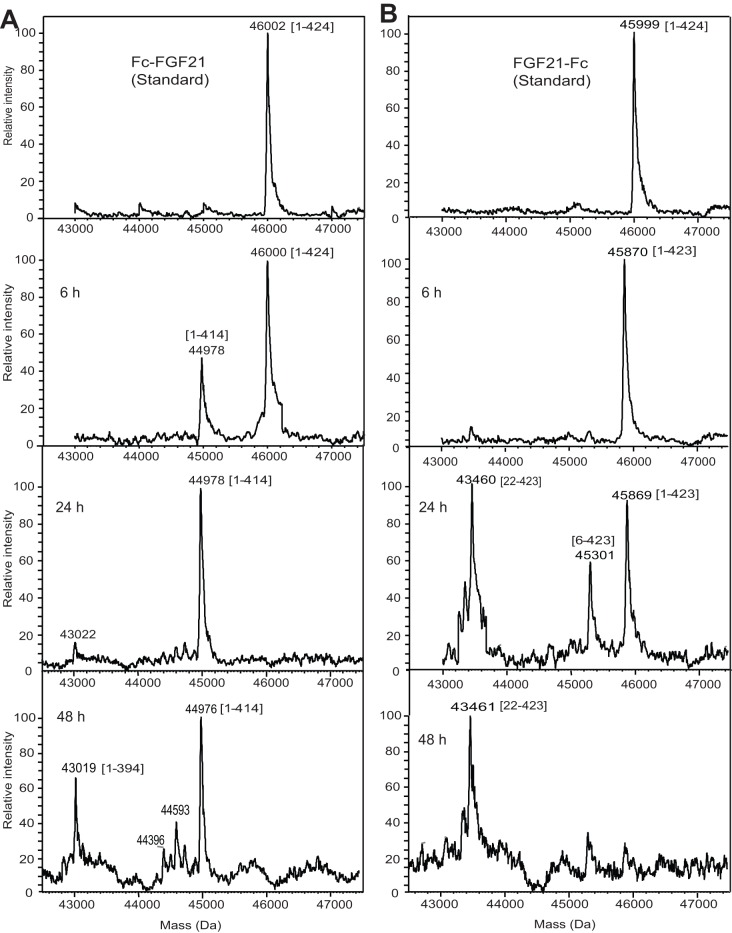
LBMS (LC-ESI-MS) analysis of Fc-FGF21 (A) or FGF21-Fc (B) in male C57BL6 mice after iv administration at 23 mg/kg.Blood samples were collected at 6, 24 and 48 h post injection and were pooled from 6 mice per time point for LBMS analysis. Top panel: standards. The predicted fragment is indicated in the bracket next to the mass peak.